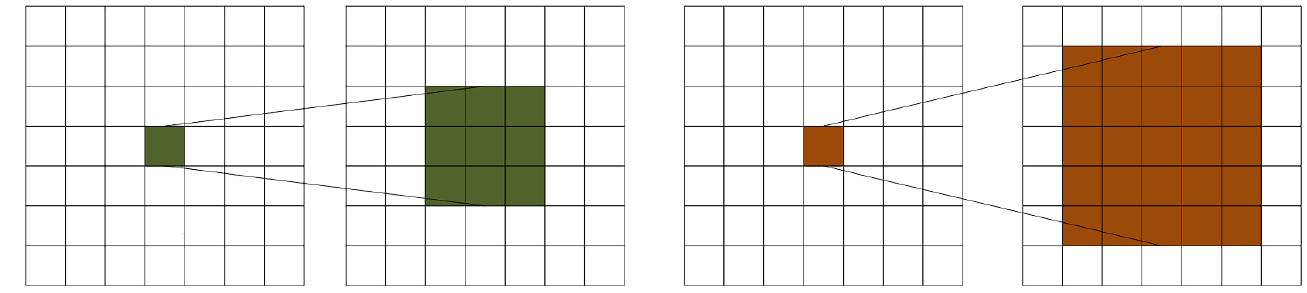
Figure 2. Different size convolutions correspond to different perceptual fields.